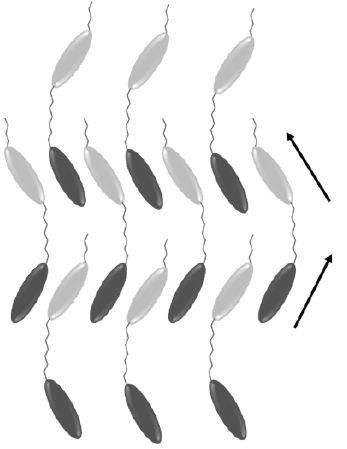
Figure 8. Sketch of the molecular arrangement in the intercalated smectic C phase. The arrow indicates the local tilt direction.